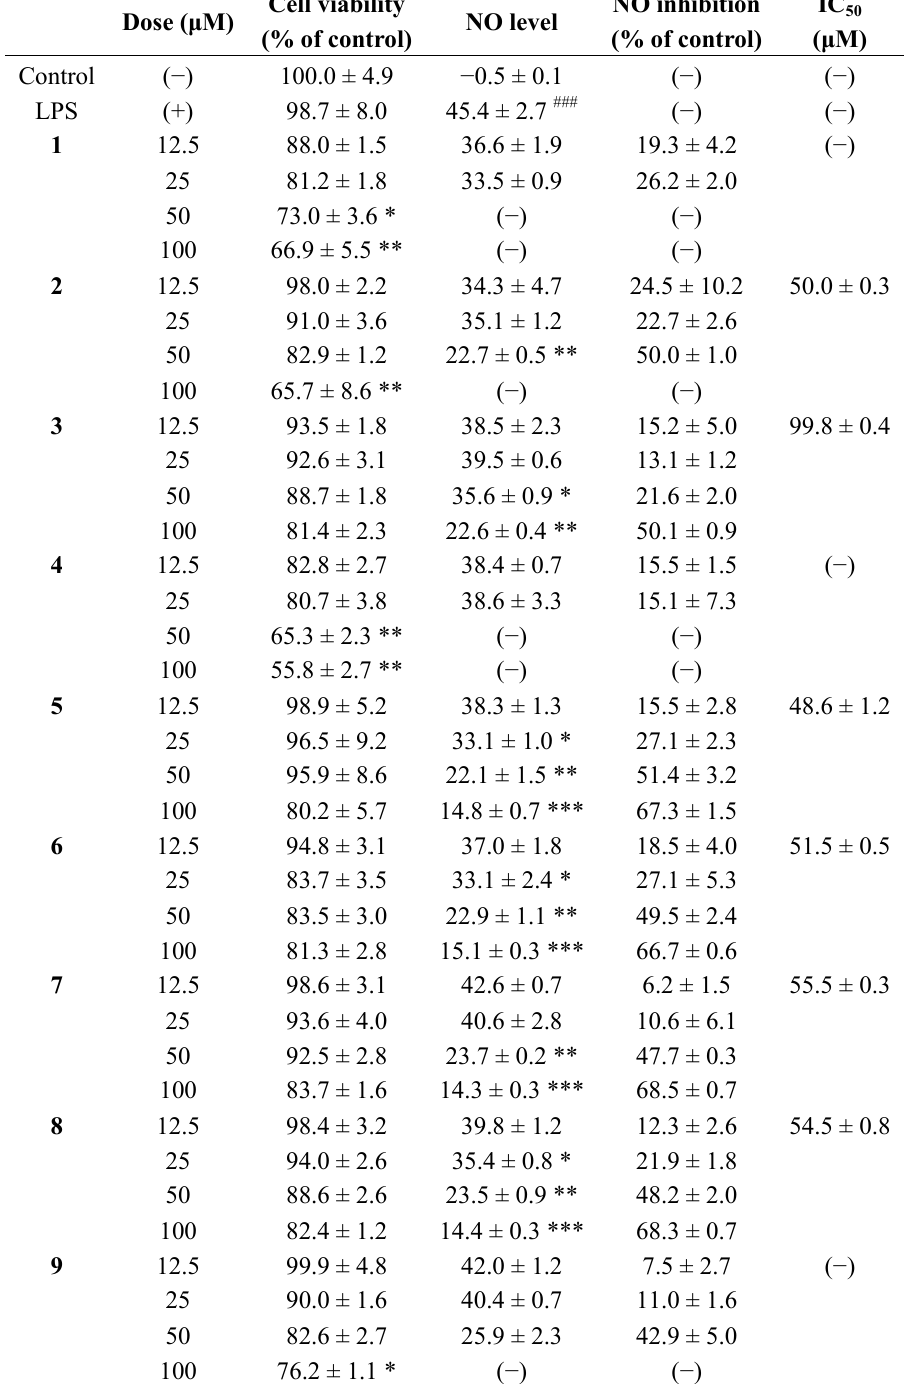
Table 1. Inhibitory effects of purified samples from the leaves of A. reticulata on LPS-induced i NOS-dependent NO production in RAW 264.7